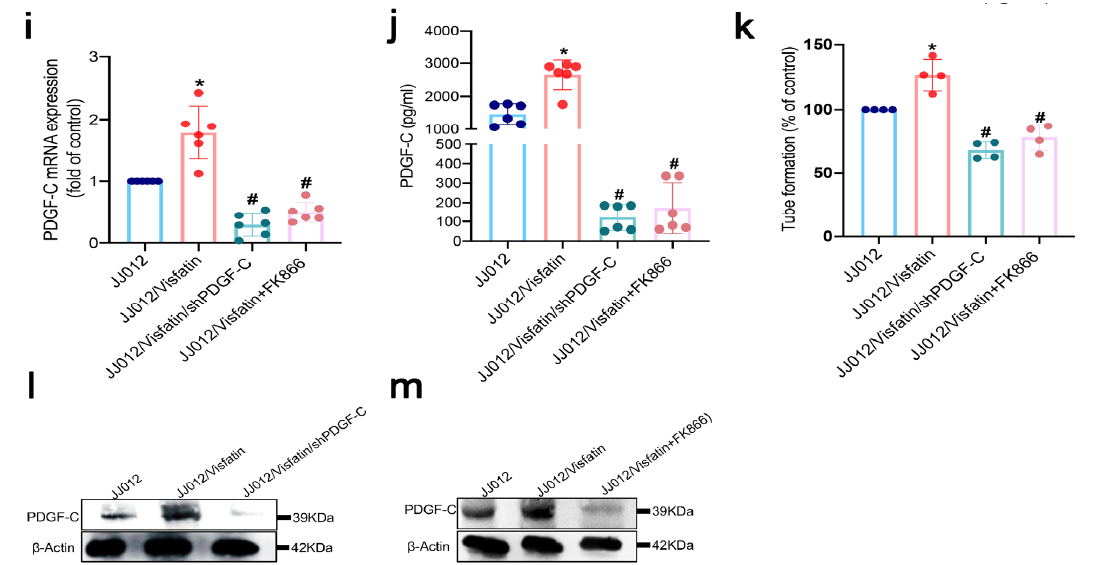
Figure 2. Visfatin regulated PDGF-C-dependent EPC angiogenesis. ( a ) High-dose visfatin (50 ng/mL) increased levels of angiogenesis factor expression in chondrosarcoma cells; ( b – f ) chondrosarcoma cells were stimulated with varying concentrations of visfatin (10–50 ng/mL) or high-dose visfatin alone (50 ng/mL) for the indicated time intervals for up to 24 h, then assayed by RT-qPCR, Western blot, and ELISA for PDGF-C expression; ( g , h ) chondrosarcoma cells were incubated with visfatin for 24 h and then stimulated with PDGF-C or IgG antibody (1 µ g/mL) for 30 min, prior to CM collection and its application to EPCs; ( i , j , l , m ) protein and mRNA levels of PDGF-C expression in JJ012/visfatin/PDGF-C shRNA and JJ012/visfatin-FK866 (100 nM) cells were detected by Western blot, RT-qPCR and ELISA; ( k ) EPCs were incubated with the indicated CMs for 5 h, then photographed under a microscope to measure EPC tube formation (scale bar = 200 µ m). Quantitative results are expressed as means ± SD. Compared with the control group, * p -values < 0.05; compared with the visfatin-treated group, # p -values <